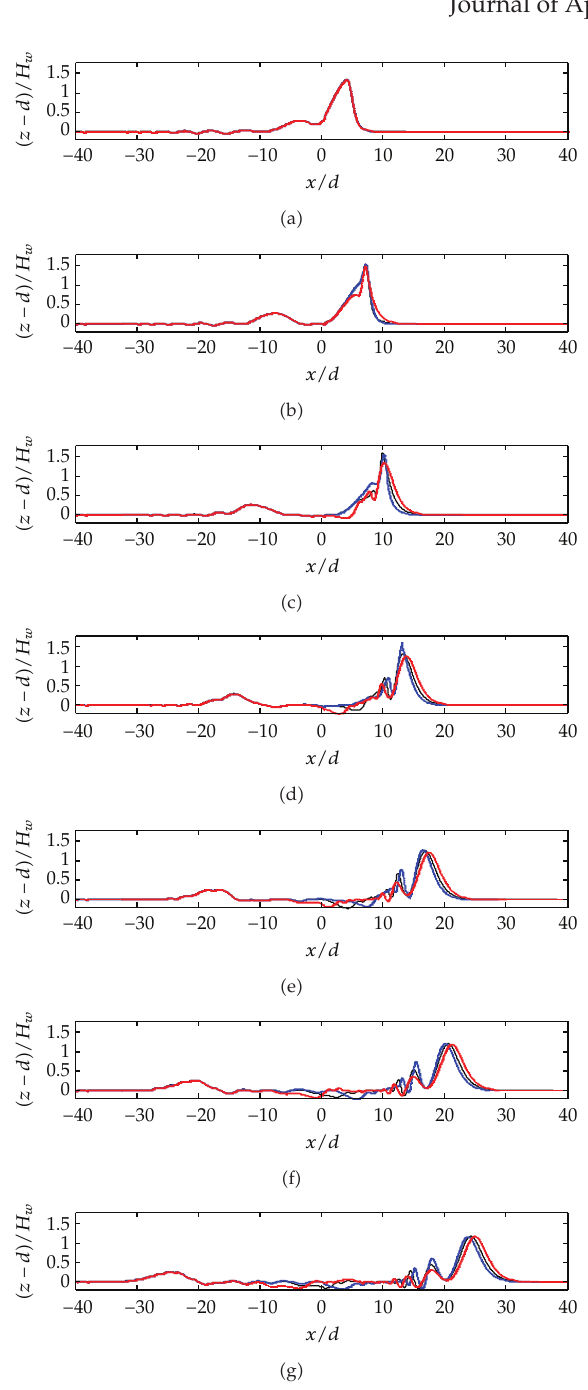
Figure 5: The e ff ect of breakwater width on wave transformation for w (cid:7) 50 . 0m black curve, w (cid:7) 40 . 0m blue curve, and w (cid:7) 30 . 0m red